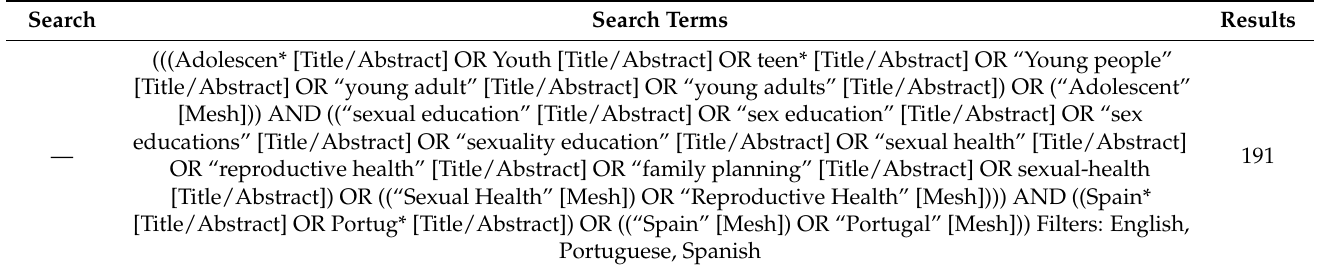
Table A5. Search at Medline via PubMed in 6 April 2021.